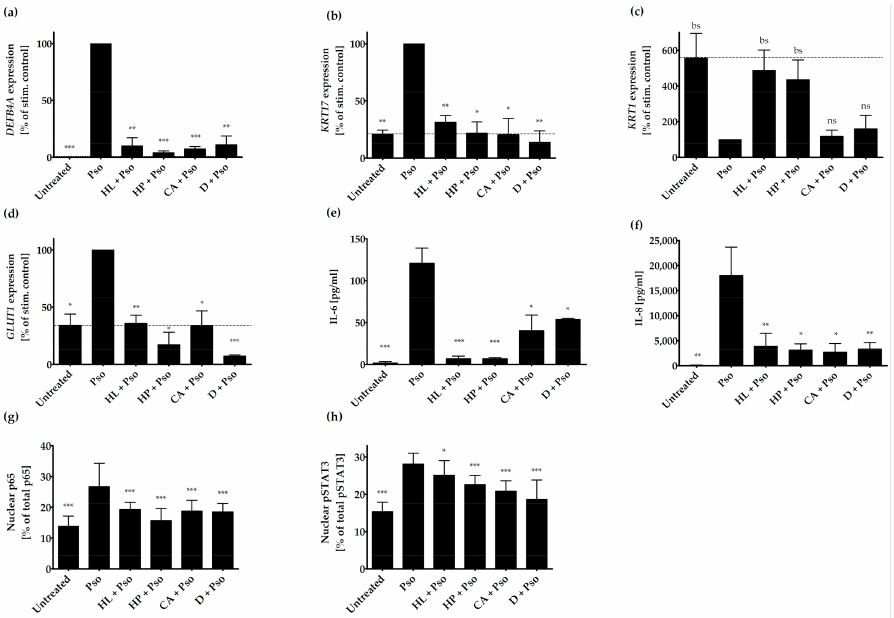
Figure 2. Effect of plant extracts on psoriasis-related genes or proteins. HPK were incubated with or without plant extracts (1 µ g/mL HL ( Humulus lupulus ), 1 µ g/mL HP ( Hypericum perforatum ), 2 µ g/mL CA ( Curcuma amara ) or 0.3 µ g/mL D (dithranol) for 2 h and then stimulated with psoriasis cytokines (IL-17A, TNF- α and IL-22; 20 ng/mL each) for 22 h (Pso). ( a ) DEFB4A, ( b ) KRT17, ( c ) KRT1 and ( d ) GLUT1 mRNA expression was analyzed by real time qRT-PCR ( n = 3). ACTB was used as reference gene for normalization. Protein level of secreted IL-6 ( e ) and IL-8 ( f ) was measured in the cell culture supernatant by ELISA ( n = 3). The dotted line indicates the value of the untreated sample. Data shown as mean ± SD of three independent experiments. ( g ) Effect of plant extracts on p65 subunit of NF- κ B and ( h ) pSTAT3 nuclear translocation. HPK were pre-treated with either 1 µ g/mL HL ( Humulus lupulus ), 1 µ g/mL HP ( Hypericum perforatum ), 2 µ g/mL CA ( Curcuma amara ) or 0.3 µ g/mL D (dithranol) for 2 h prior to stimulation with 20 ng/mL of IL-17A, IL-22 and TNF- α . Cells were fixed, permeabilized and the p65 subunit of NF- κ B and pSTAT3 were stained using the antibodies noted in the Materials and Methods Section, while DAPI was used for nuclear staining. The % of total protein in the nucleus was measured using the Intensity Ratio Nuclei Cytoplasm Tool (RRID:SCR_018573) in ImageJ. Data shown as mean ± SD of five independent experiments with two pictures per experiment. Statistics were always one-way ANOVA with Newman-Keuls post-test. * p ≤ 0.05, ** p ≤ 0.01, *** p ≤ 0.001, bs (borderline significant): 0.1 > p > 0.05, ns-not